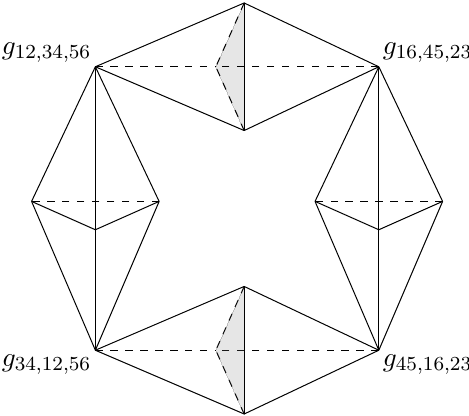
Figure 8 . The arrangement of bipyramids inside Tr + (3 ; 6). The vertices represent the intersections of the rays r i with the unit sphere S 4 . Two triangles are shaded to emphasize that they are actual 2-faces of the